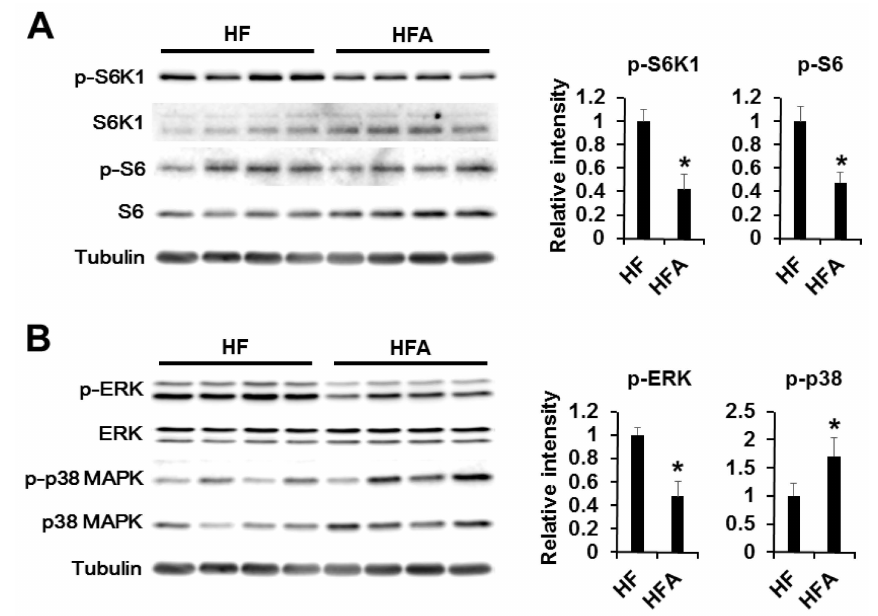
Figure 4. Central administration of ADE reduces ghrelin signaling through mTOR and ERK signaling pathways in mice fed a high-fat diet. ( A ) Effects of ICV administration of ADE (1 µ L of 10 mg/mL) on mTOR signaling pathways. The results of densitometric analysis (right) are means ˘ SDs ( n = 10 per group); * p values of < 0.05 indicate significant difference from administration with DMSO (1 µ L of 20% DMSO); ( B ) Effects of ICV administration of ADE (1 µ L of 10 mg/mL) on MAPK signaling pathways. The results of densitometric analysis (right) are means ˘ SDs ( n = 10); * p values of < 0.05 indicate significant difference from administration with DMSO (1 µ L of 20% DMSO). HF, high-fat diet with DMSO. HFA, high-fat diet with